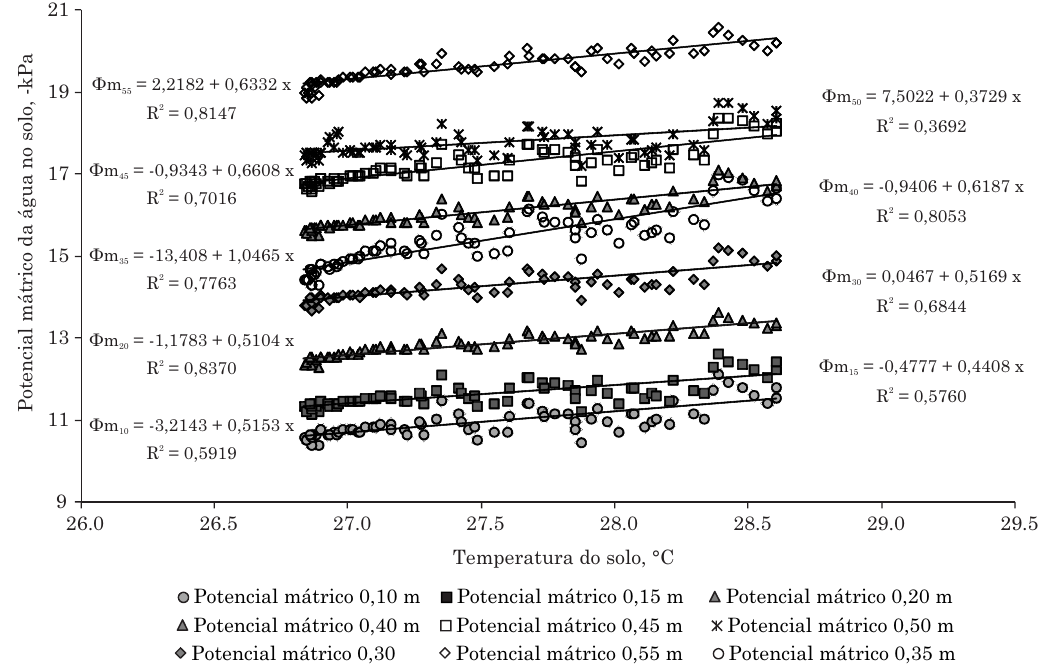
Figura 2. Regressões lineares do potencial mátrico ( φφφφφ m ) em função da temperatura média do solo (C) nas profundidades avaliadas.